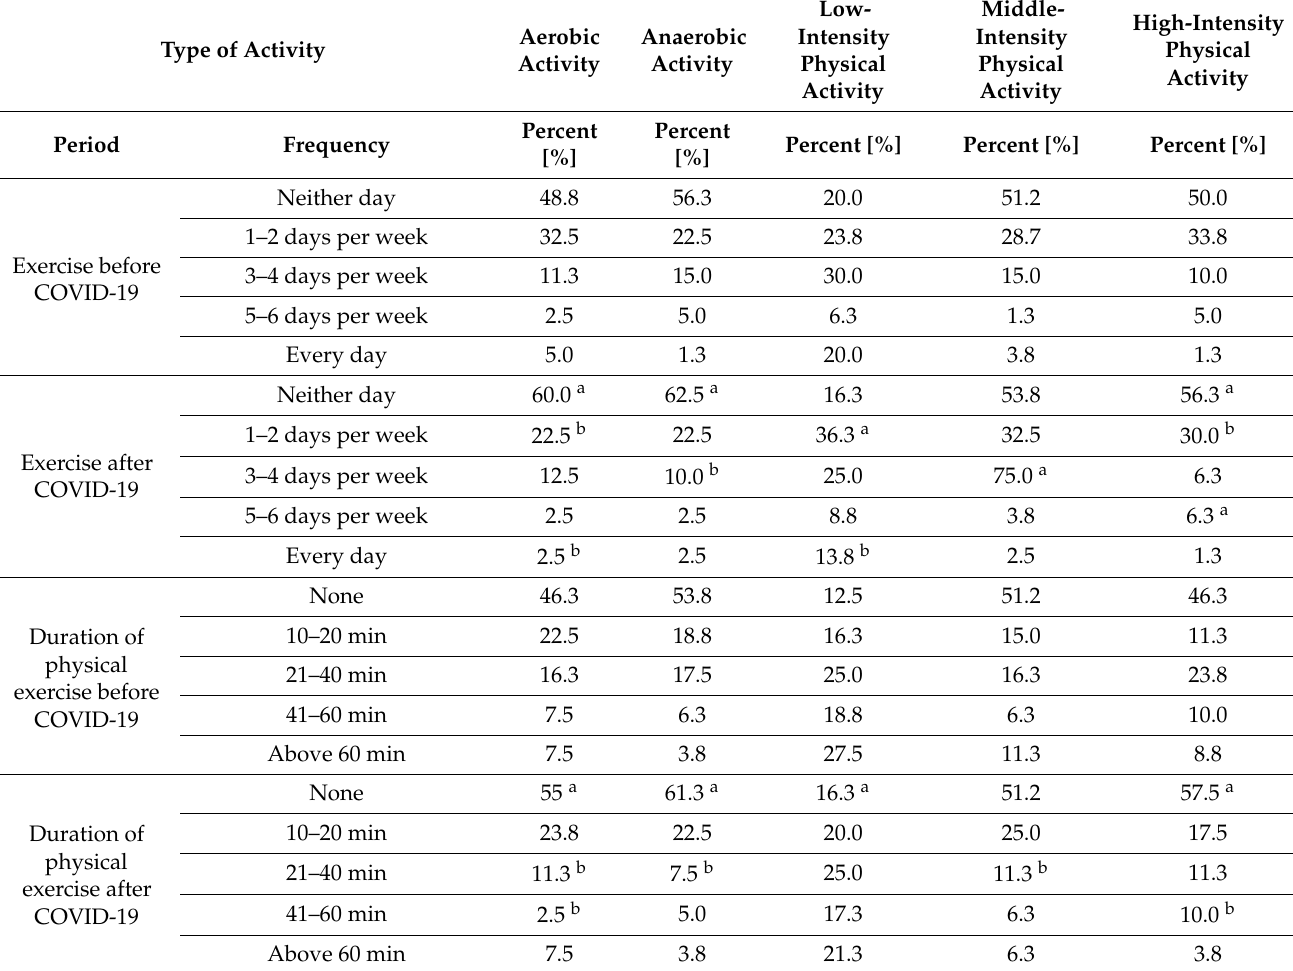
Table 3. Differences in the frequency of aerobic and anaerobic physical activity, as well as in low-, middle-, and high-intensity activity before and six months after COVID-19. Results are presented as frequency in percent from total number of participants [%]. Statistical significance was obtained using Chi-square test (X2) as follows: a = statistically significantly higher number of participants compared to activity before and after COVID-19, b = statistically significantly lower number of participants compared to activity before and after